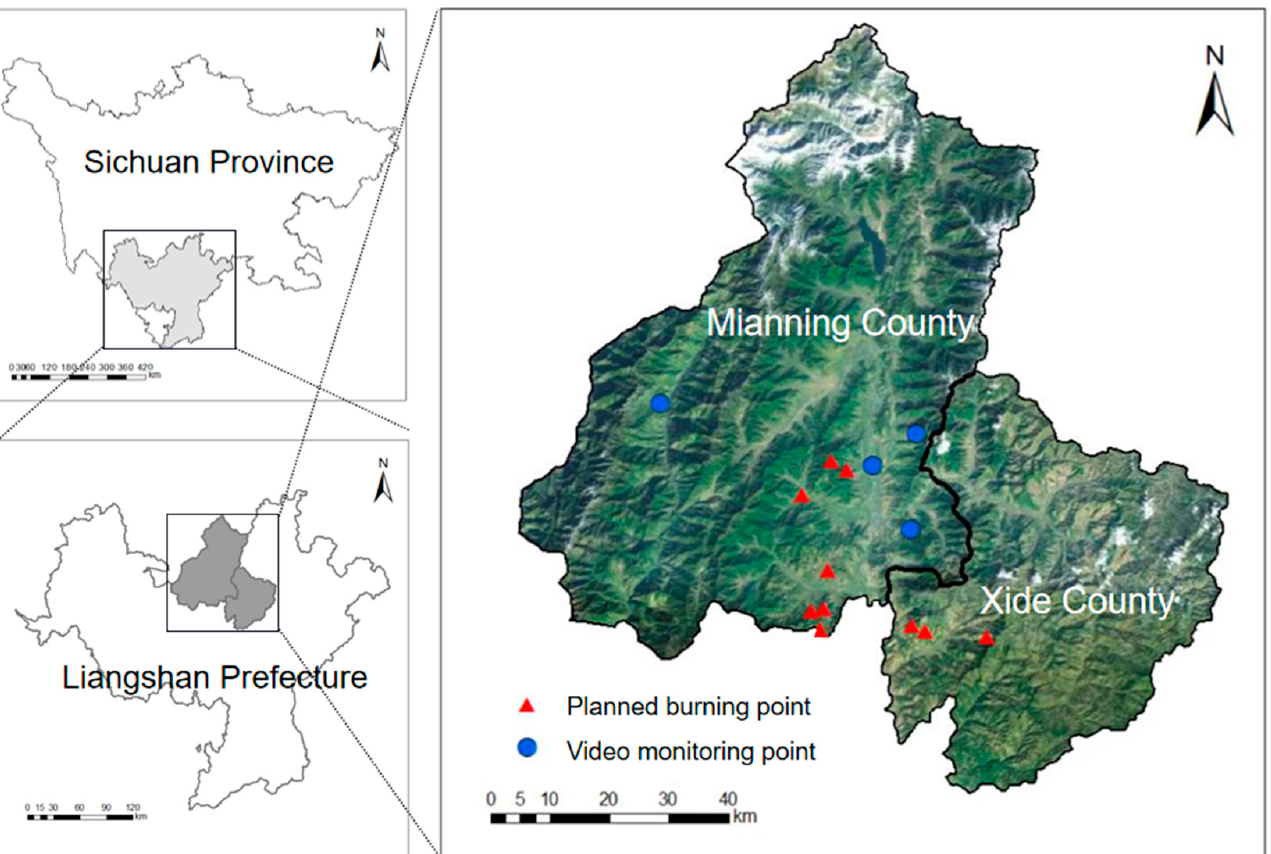
Figure 1. Location of study area and data collection points in Mianning County and Xide County. The background color map is the study area (Mianning County and Xide County) and its location.